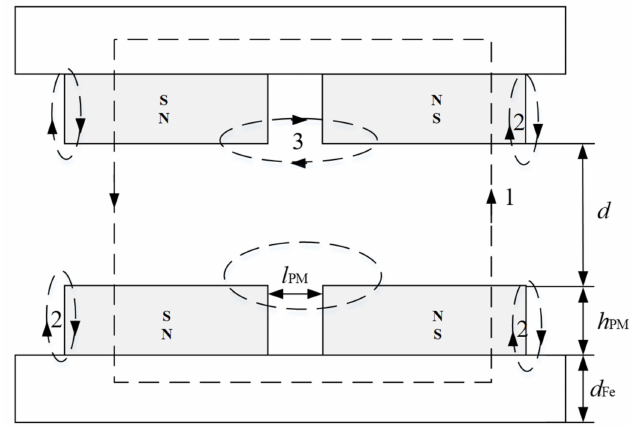
Figure 9. 2D model of the coreless double-sided AFPMSM with